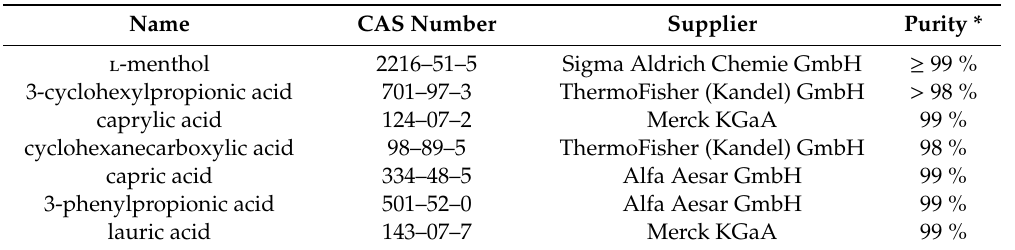
Table 4. Chemicals used in this